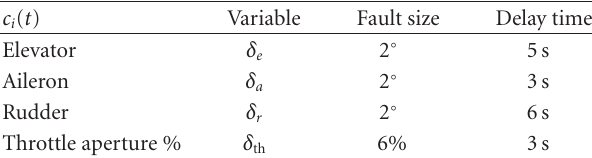
Table 4: NLGA FDI technique: minimal step faults with ν = 8.